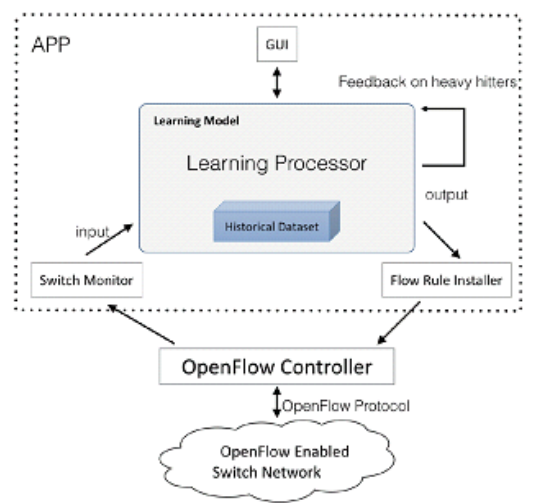
Figure 3. Architecture of heavy hitter Algorithm